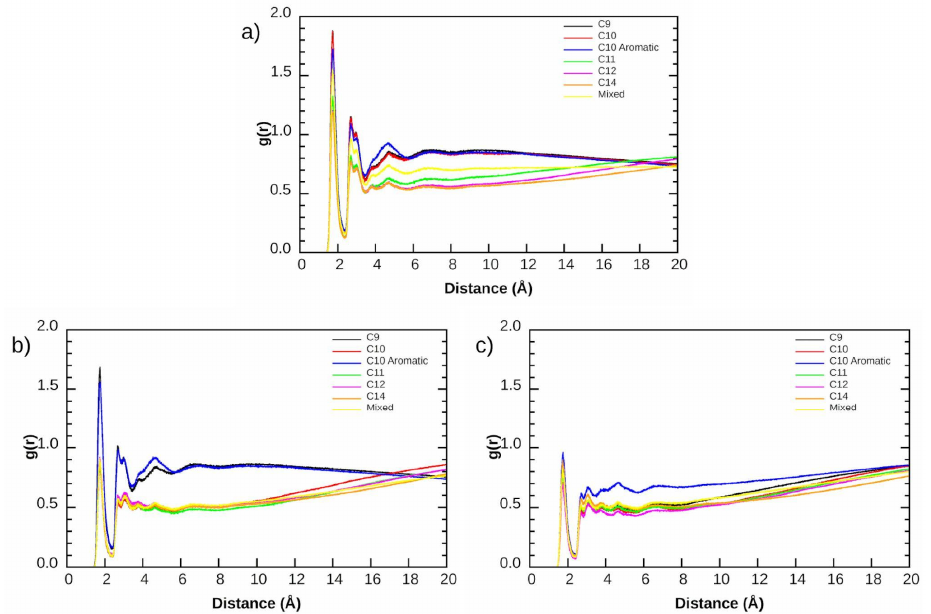
Figure 9. Radial distribution function quantifying the distribution of water (center of mass) around oxygen atoms of the NAs in ( a ) pure water, ( b ) low salinity solution (NaCl 35 g/L), and ( c ) high salinity solution (NaCl 90 g/L).